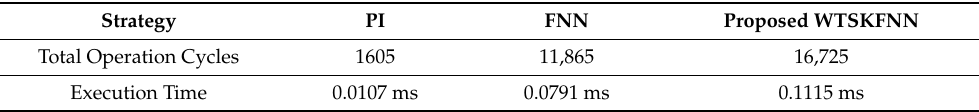
Table 3. Computation time of DSTATCOM using PI, FNN, and proposed WTSKFNN